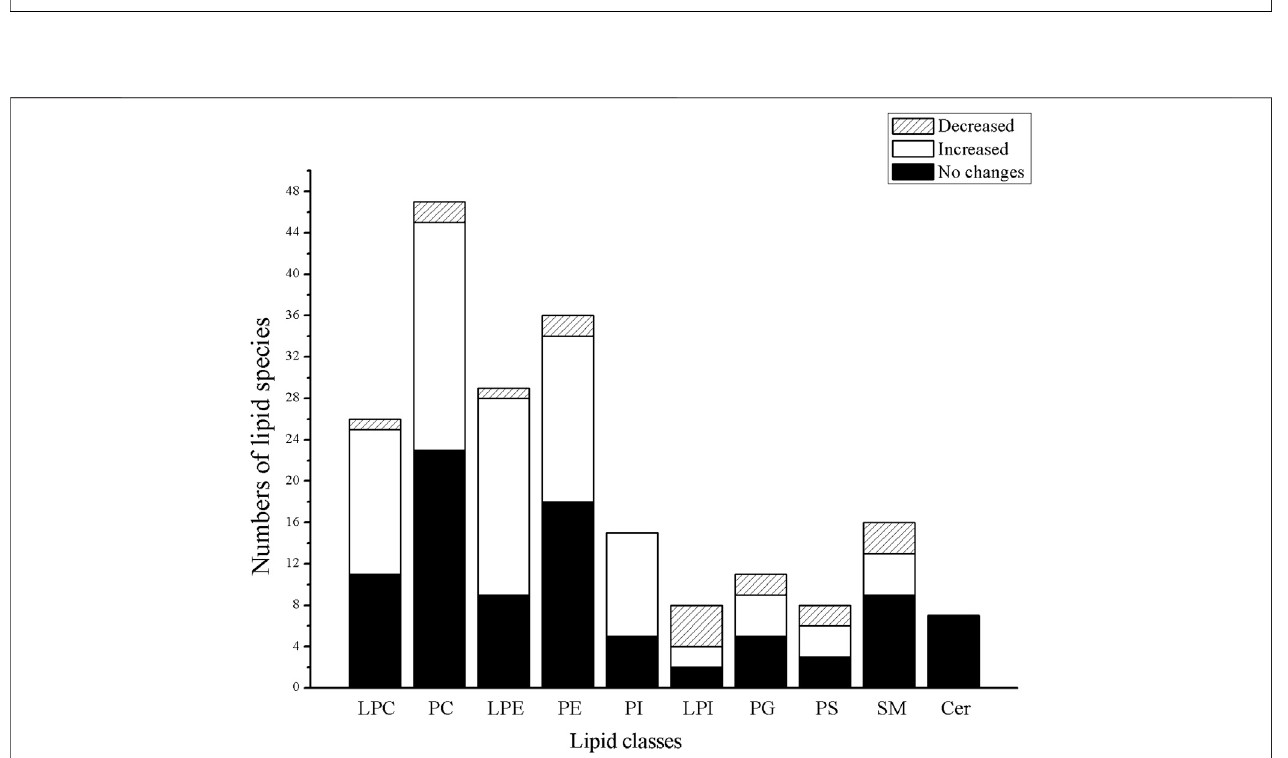
FIGURE 7 | Histograms of the varied numbers of speci fi c lipid classes between LPS + HSW and the LPS group.